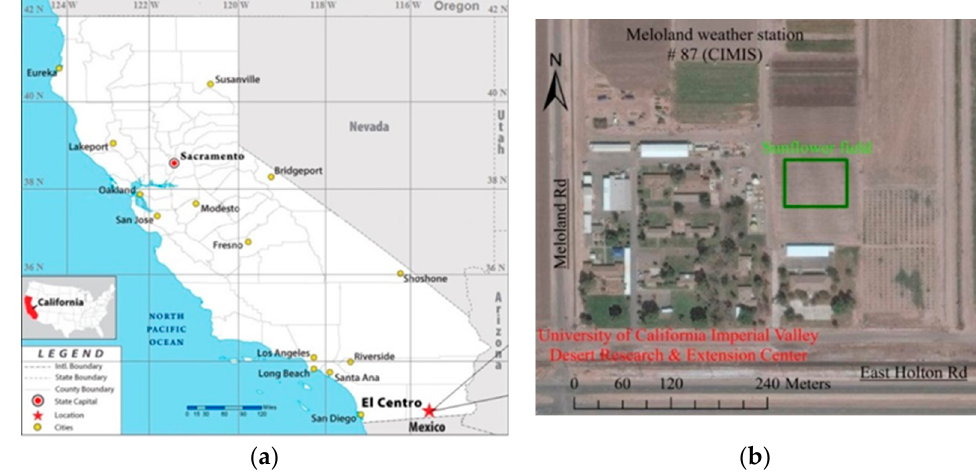
Figure 1. The location map of ( a ) the UC Desert Research Center (DREC) and ( b ) the experimental field within DREC.